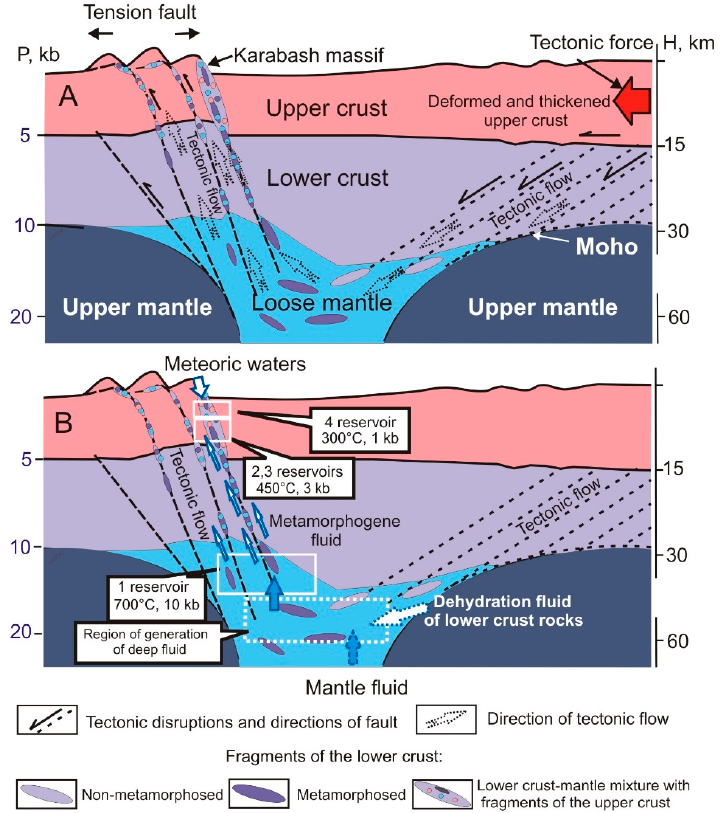
Figure 5. Model of the formation of the Karabash ultramafic massif and sources of ore-forming fluids. ( A ) Geodynamic model and ( B ) fluid model.